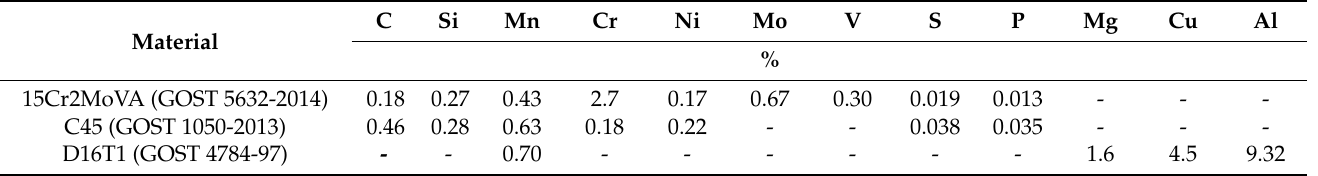
Table 1. The chemical composition of the